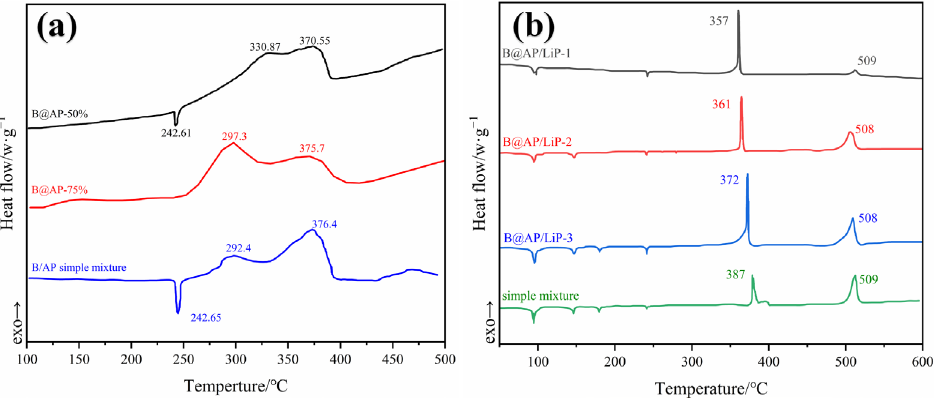
Figure 5. The DSC curves of experimental samples ( a ) in an air atmosphere [29,75]; and ( b ) in a N 2 atmosphere (the crystallization temperatures of B@AP/LiP - 1, B@AP/LiP - 2, and B@AP/LiP - 3 are 60 °C, 70 °C, and 80 °C, respectively [73]).